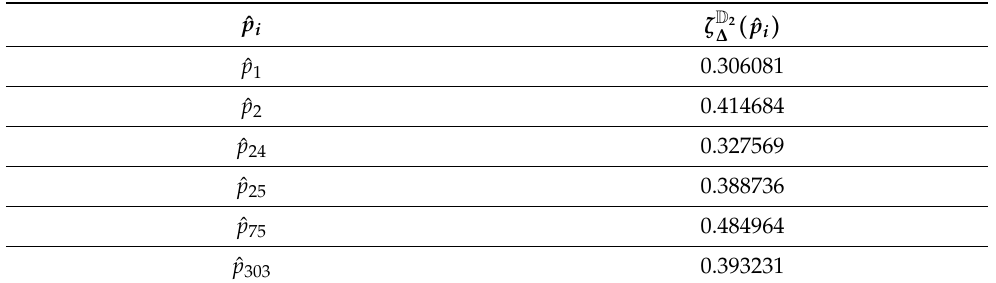
D 2 ∆ for each ˆ p i .